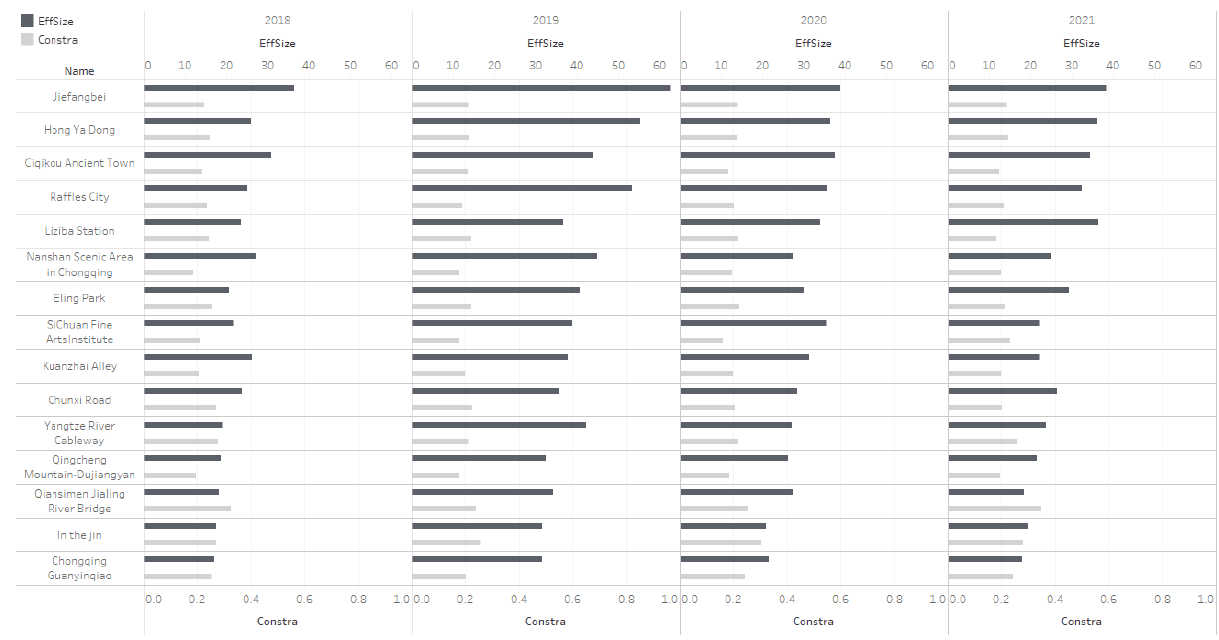
Figure 8. Structural holes of tourist attractions in the Chengdu–Chongqing Economic Circle in 2018– 2021.